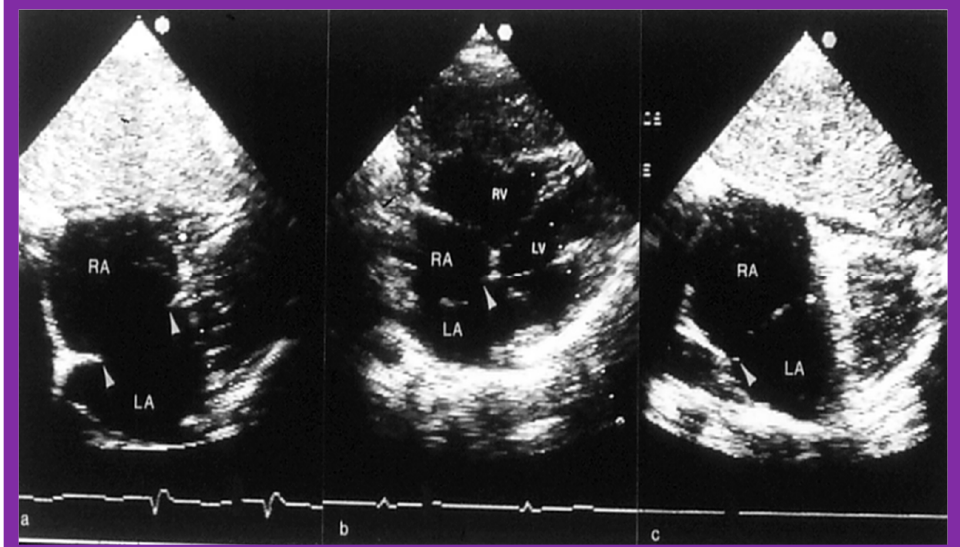
Figure 12. Two-dimensional echocardiograms of atrial septal defects (ASDs) in three different patients to illustrate deficient atrial septal margins. In ( a ) superior and inferior rims are small, in ( b ) the inferior septal rim is deficient, and in ( c ) the superior rim is tiny; the rims are shown with arrowheads. These ASDs are considered unsuitable for transcatheter device occlusion, because the rims of the ASD are inadequate for the device to achieve a good grasp on the atrial septum. LA, left atrium; LV, left ventricle: RA, right atrium; RV, right ventricle. Reproduced from Reference [26].